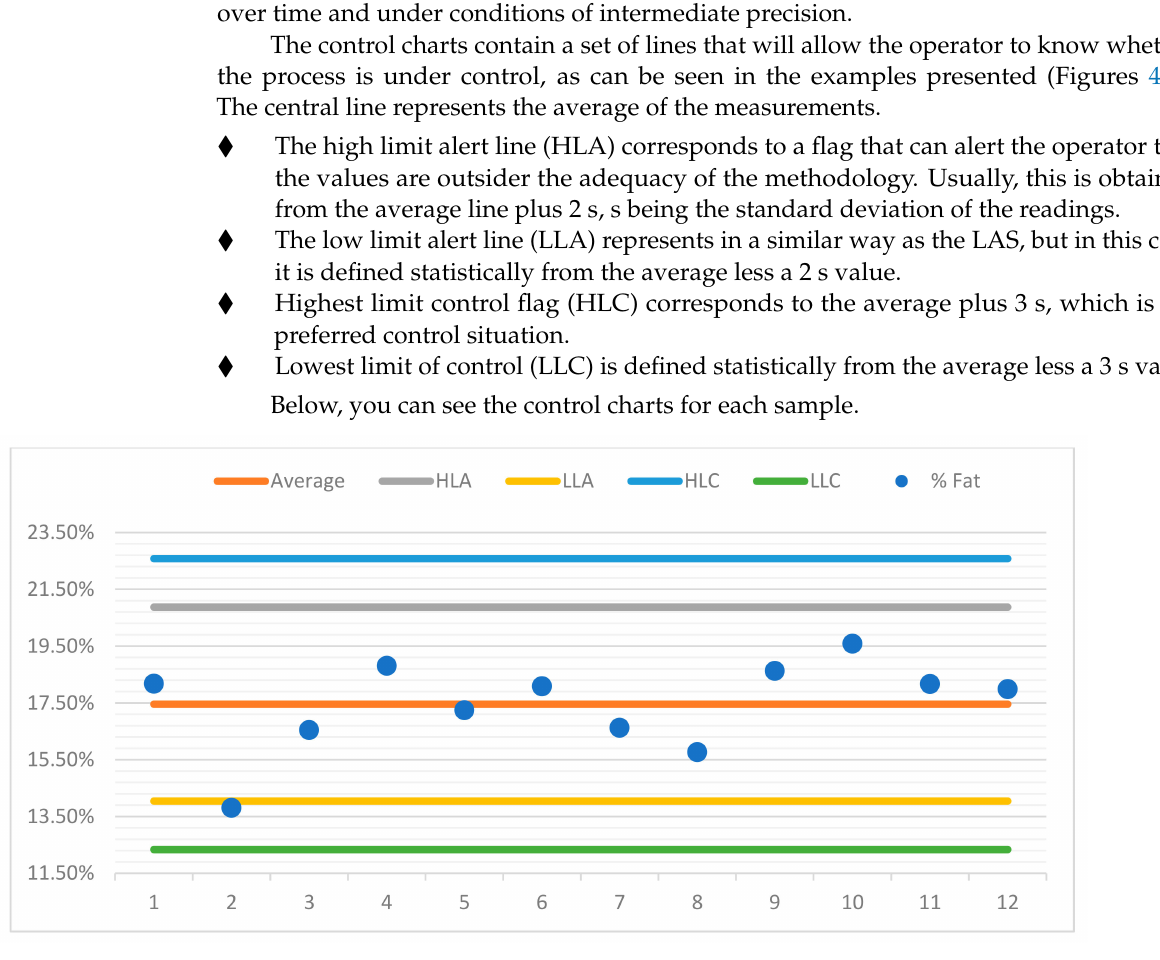
Figure 4. Control chart sample